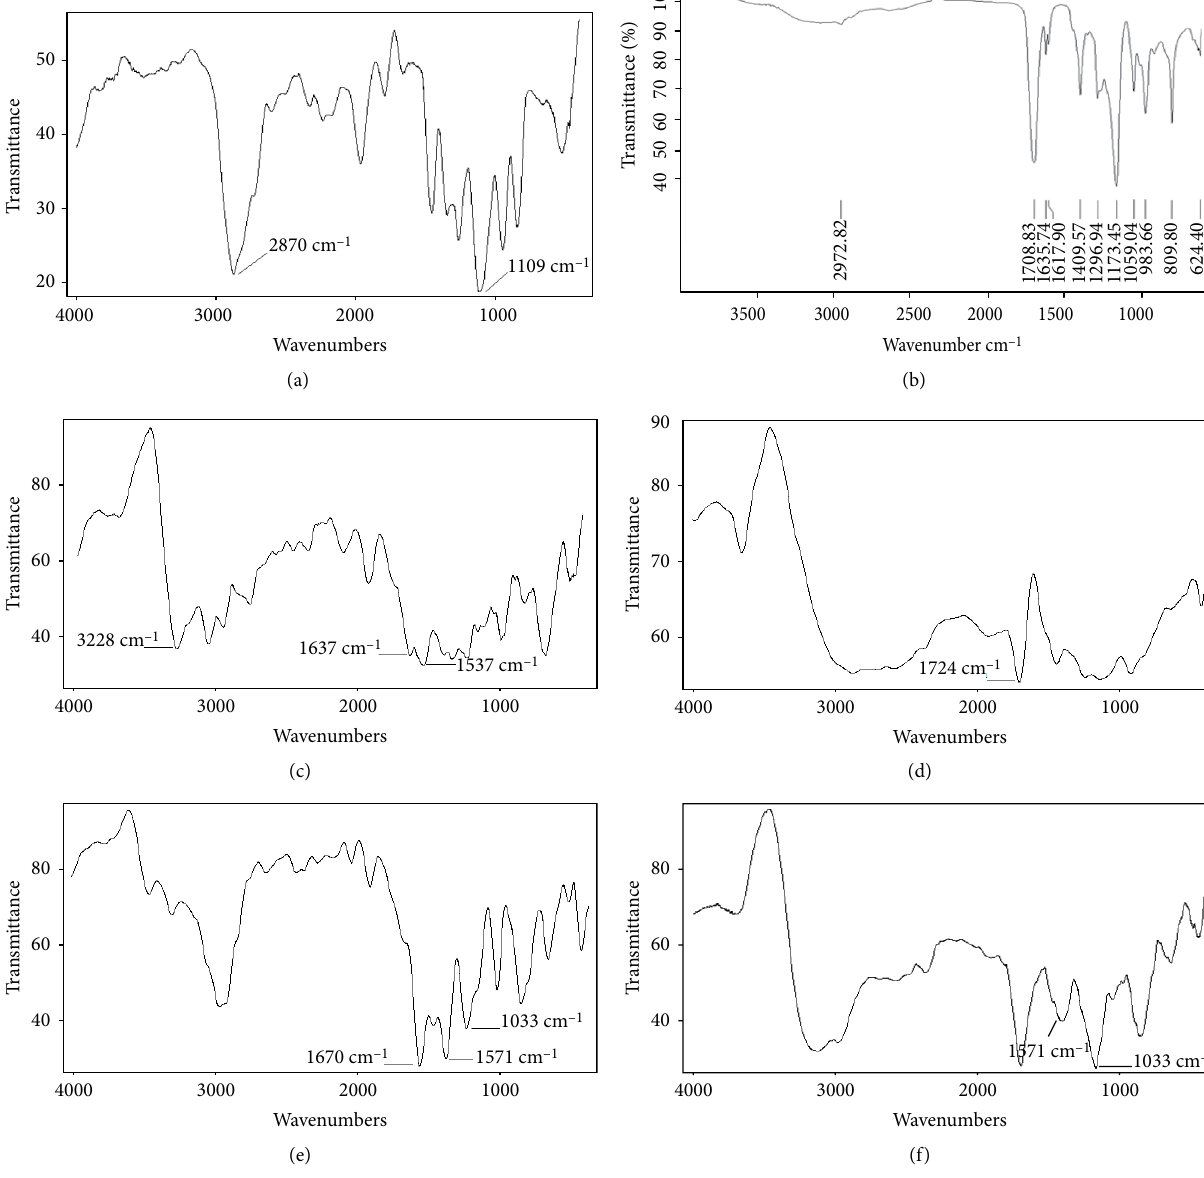
Figure 5: (a) FTIR spectra of PEG. (b) FTIR spectra of methacrylic acid. (c) FTIR spectra of MBA. (d) FTIR spectra of PEG-p (MAA). (e) FTIR spectra of naproxen sodium. (f) FTIR spectra of drug loaded